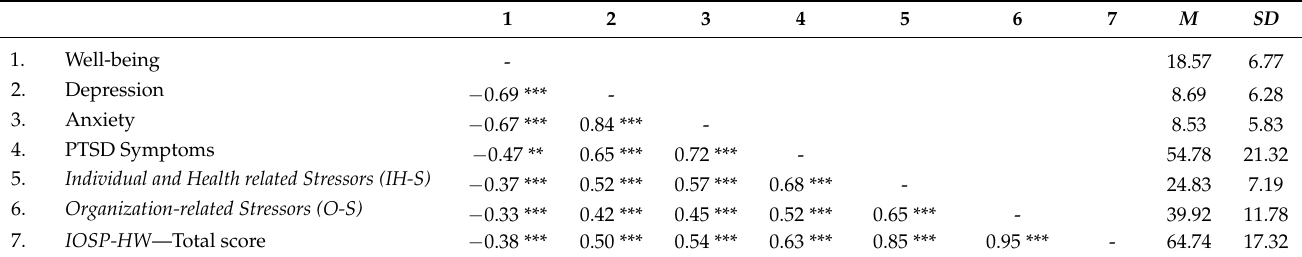
Table 6. Pearson correlations between the Individual and Organization related Stressors in Pandemic Scale for Healthcare Workers (IOSPS-HW) subscale and total scores, Well-being, Depression, Generalized Anxiety and PTSD symptoms.